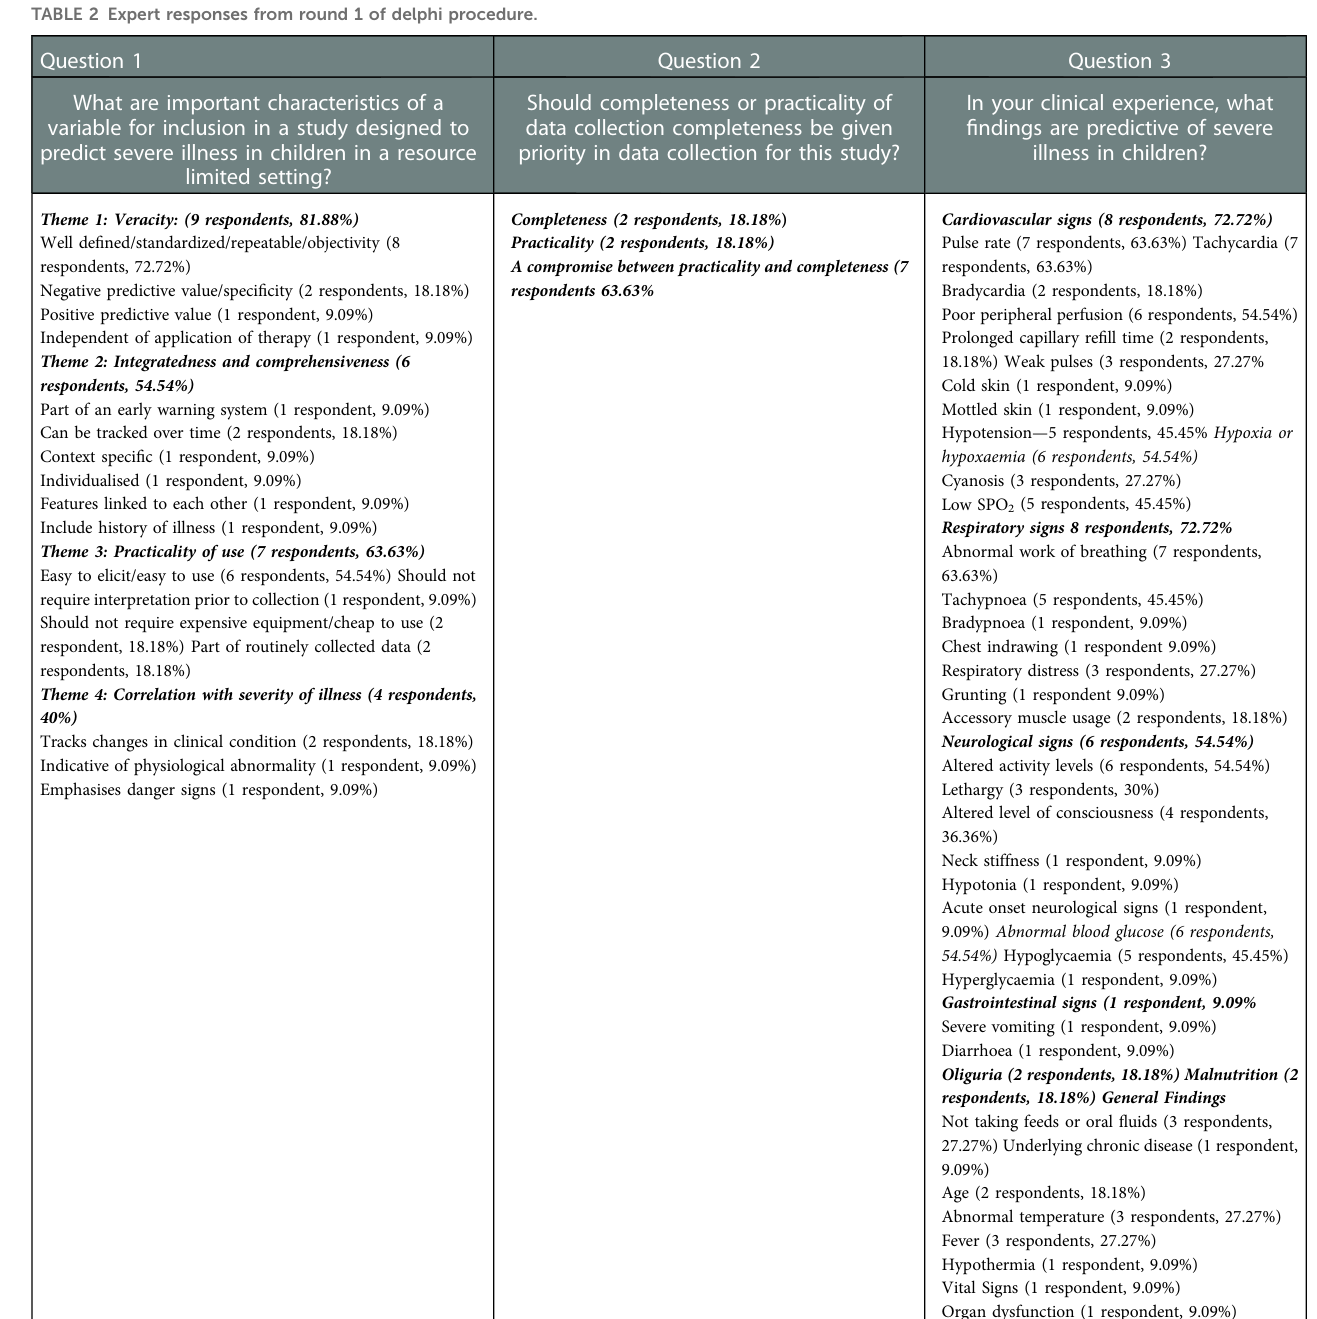
TABLE 2 Expert responses from round 1 of delphi